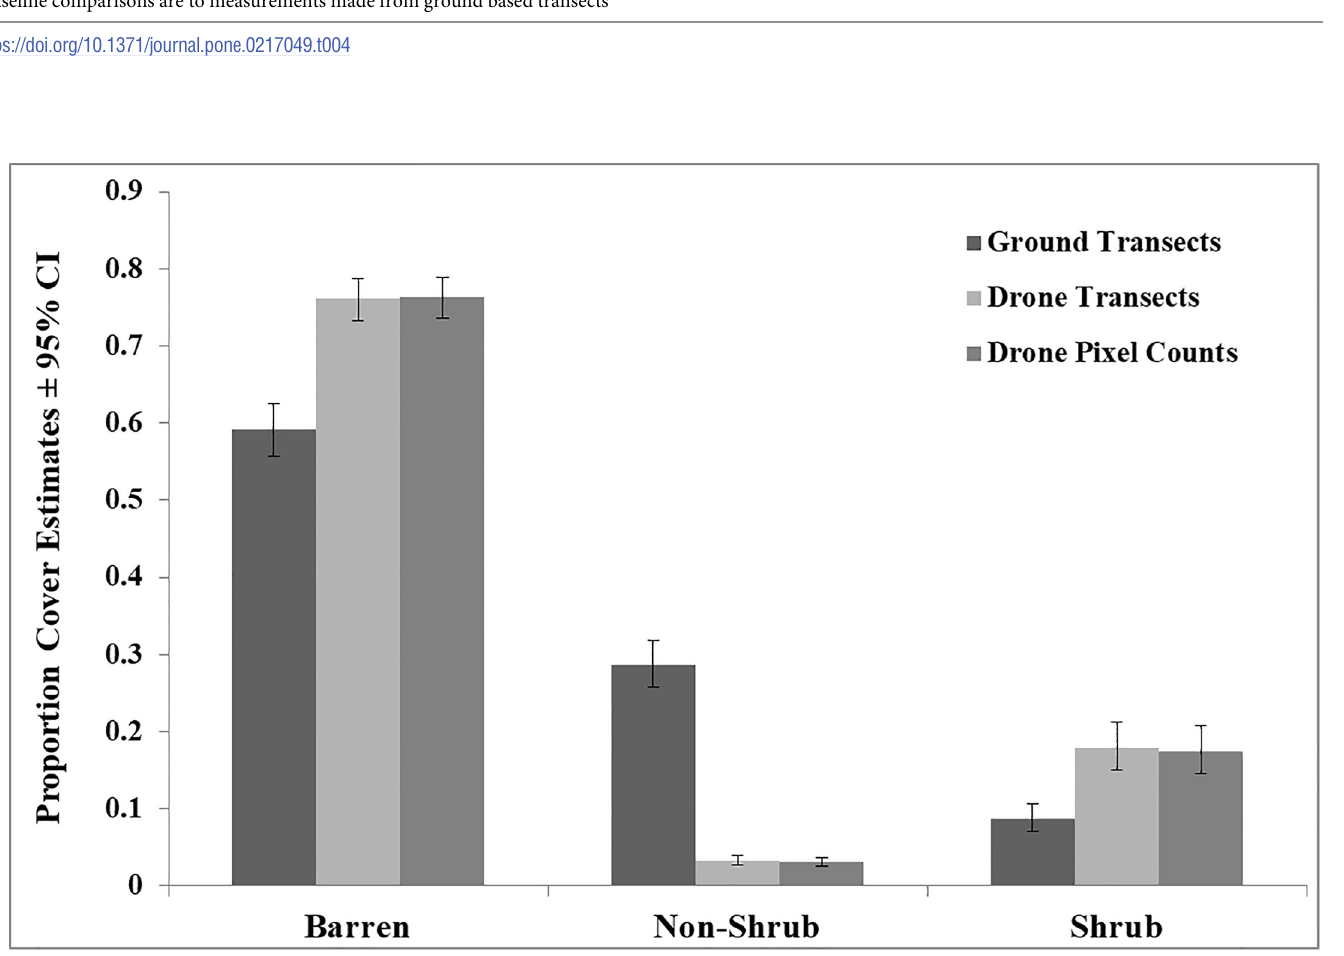
Fig 4. Mixed model estimates of proportion land cover type from three different methods of data collection. Ground transects data collected as linear transects, drone transects are the same transects overlaid on classified drone imagery (see Methods section) with land cover values were extracted every meter, and drone pixel counts based on the enumeration of pixels for each land cover type as a proportion of all pixels in each cell. Drone estimates made from imagery collected at 75 m AGL. Cover data obtained from 92 cells across 5 study plots.